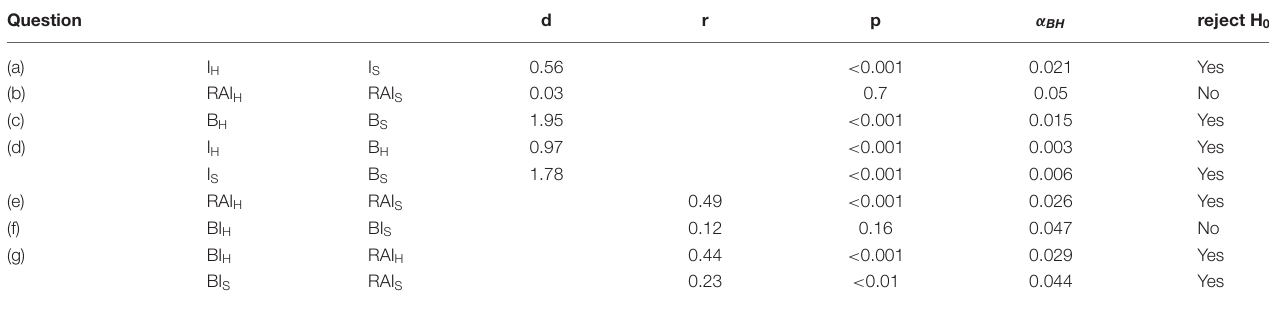
TABLE 3 | Summary of